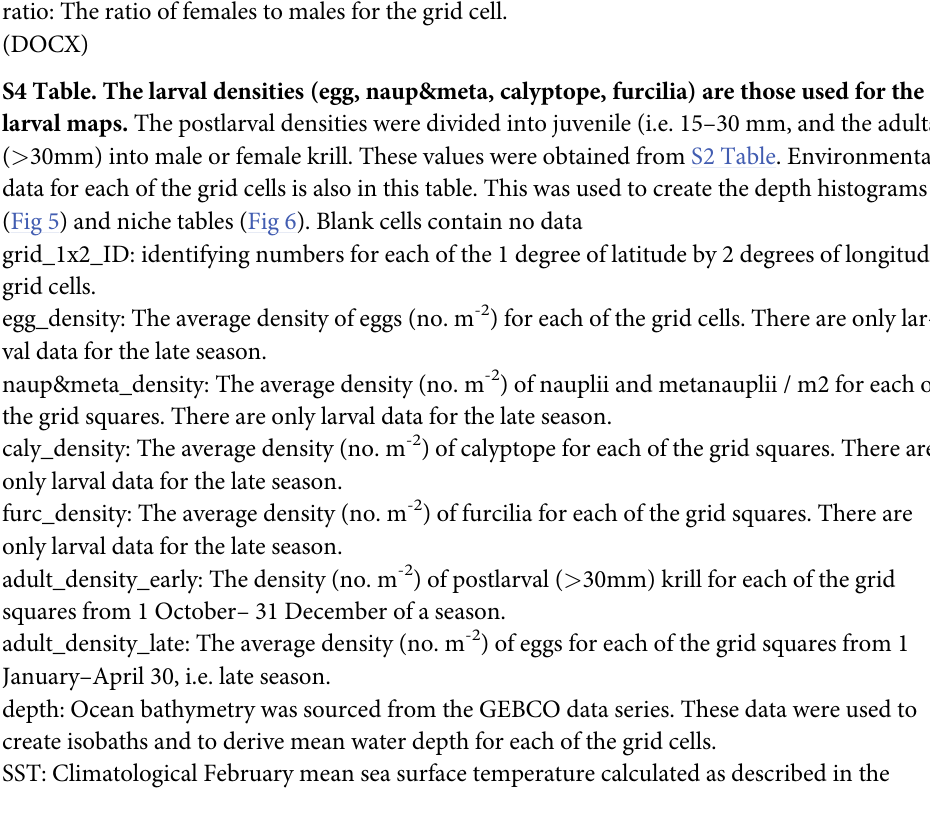
S4 Table. The larval densities (egg, naup&meta, calyptope, furcilia) are those used for the larval maps. The postlarval densities were divided into juvenile (i.e. 15–30 mm, and the adults ( > 30mm) into male or female krill. These values were obtained from S2 Table. Environmental data for each of the grid cells is also in this table. This was used to create the depth